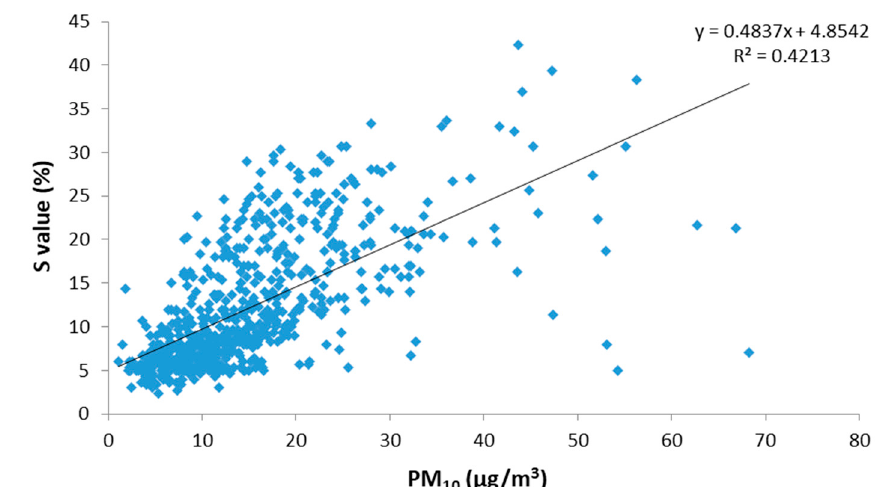
Figure 6. Relationship between saturation (S HSV ) and gravimetric PM 10 concentration for all daily samples collected during 2015 at Badajoz and Monfragüe (total of 700 samples).